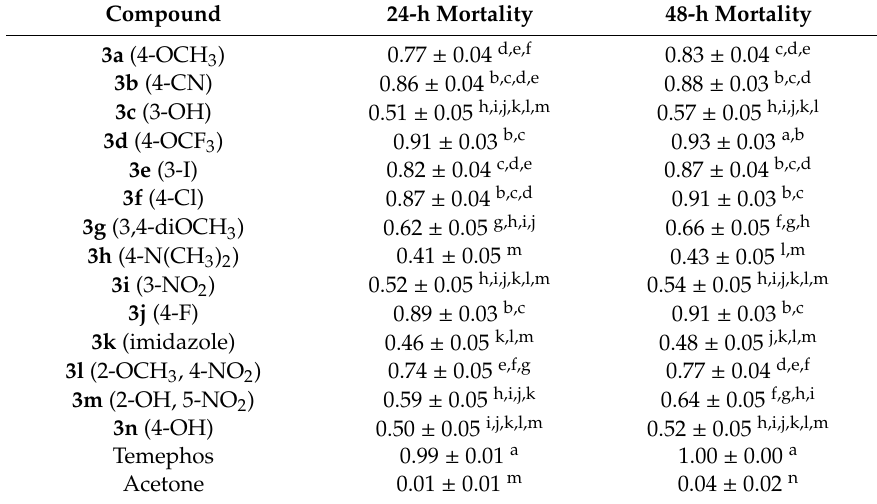
Table 4. Mortality of Anopheles arabiensis larvae exposed to test compounds 3a – n at 4 µ g / mL.